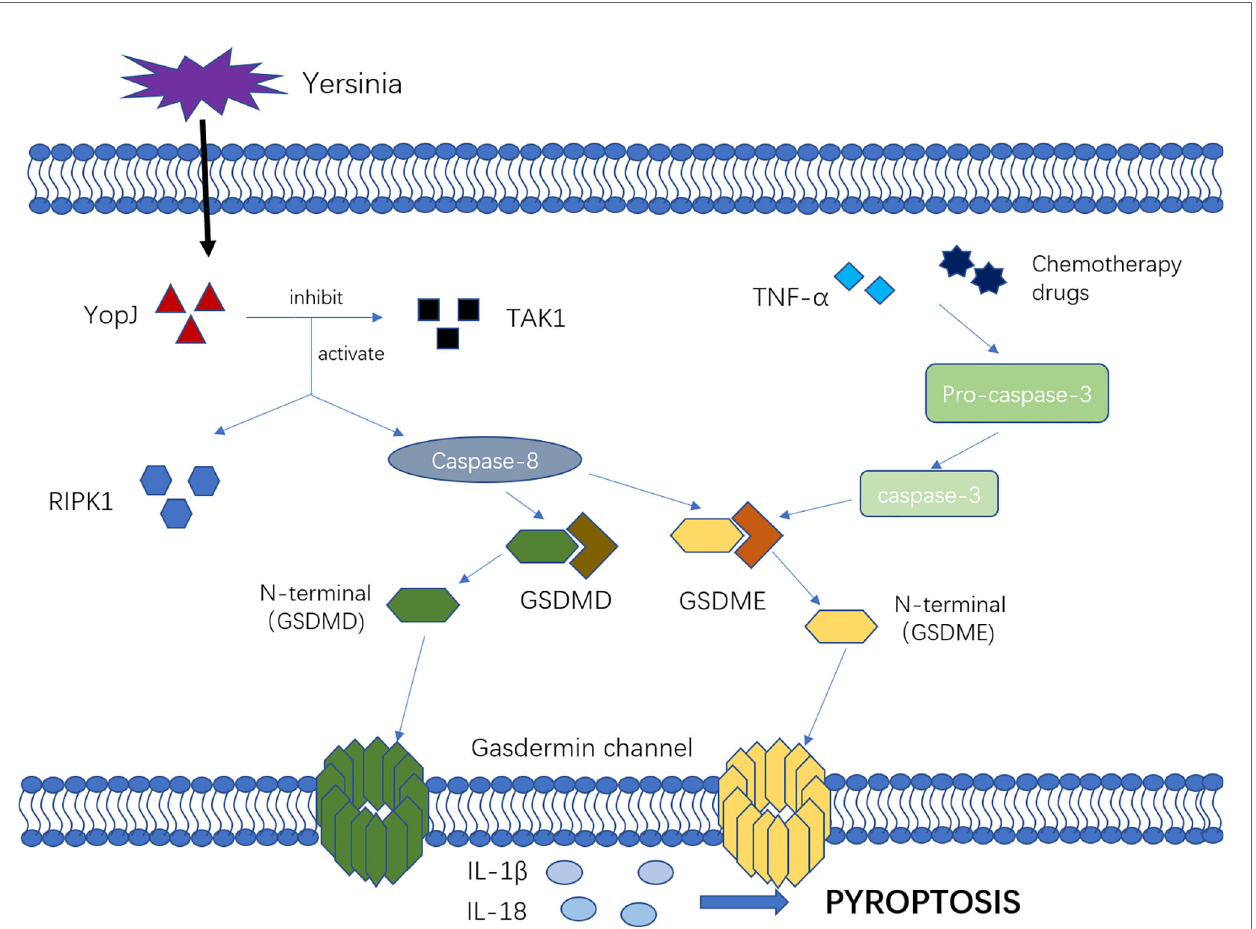
FIGURE 2 | The mechanism of new pyroptosis pathways. Activated by TNF- a or chemotherapy drugs, Caspase-3 cleavage and activate GSDME, releasing N- terminal binding to the cell membrane, forming “ gasdermin channel ” and inducing cell pyroptosis. Additionally, the pathogenic Yersinia could inhibit TAK1 via the effector YopJ, and then activated RIPK1 as well as Caspase-8, which would cleave GSDMD and GSDME, forming the “ gasdermin channel ” on the cell membrane, mediating pyroptosis and leading to the in fl ammatory